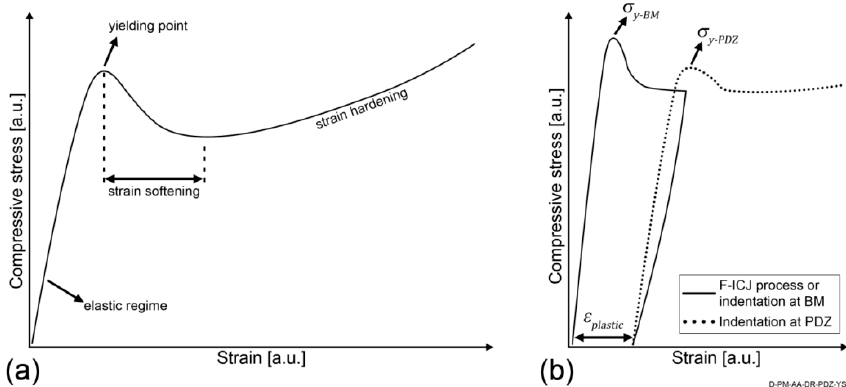
Figure 7. ( a ) Behavior of PEI under uniaxial compression (based on [27,32]). ( b ) Yielding of PEI up to strain softening (solid curve), and reloading the yielded PEI during microhardness (dotted curve). Adapted from [19].